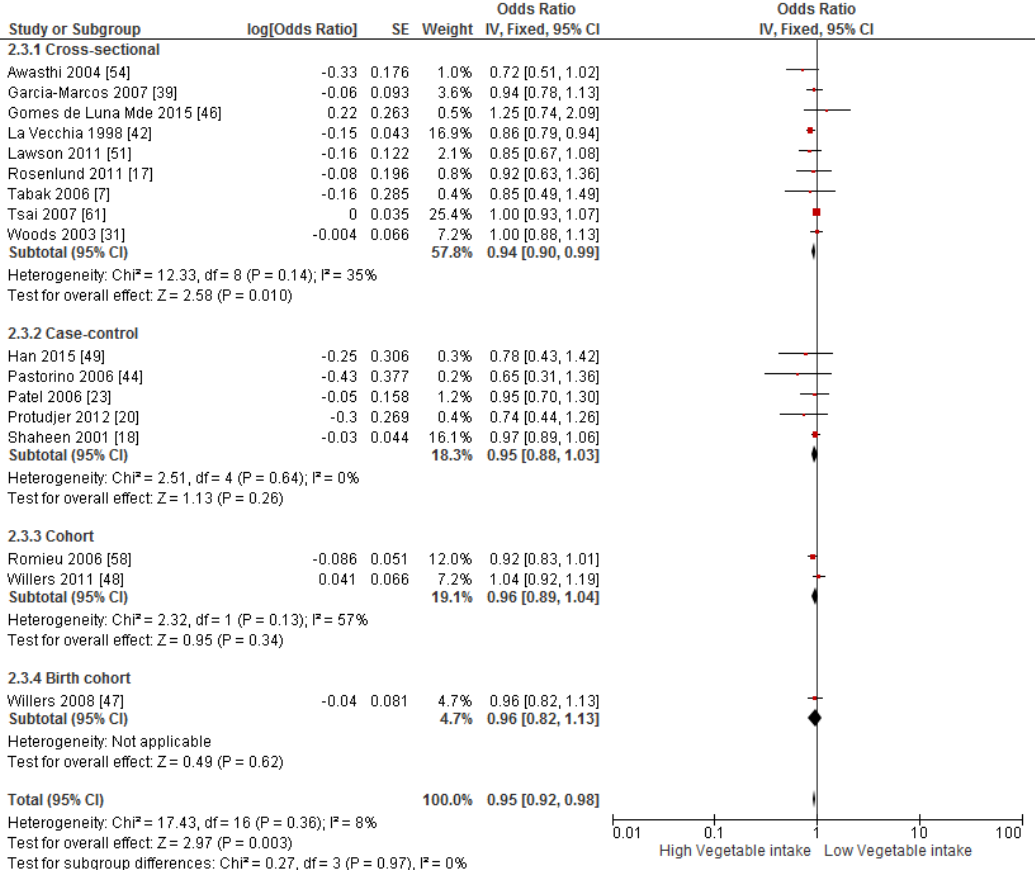
Figure 5. Meta-analysis of the association between vegetable intake and risk of prevalent asthma. Nutrients 2017 , 9 , 341